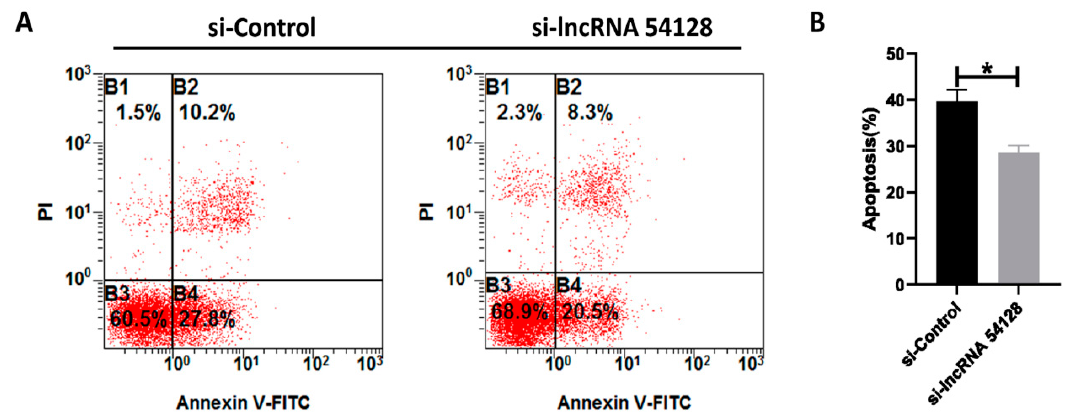
Figure 7. Downregulation of LncRNA 54218 specifically inhibits apoptosis in LMH cells with FAdV-4 infection. LMH cells were transfected with either the siControl or si LncRNA 54218 and then infected with FAdV-4 (MOI = 0.1) for 36 h. ( A ) The cell samples were dual-labelled with Annexin V and PI and analyzed by flow cytometry. ( B ) The proportions of apoptotic cells among the total cells. The data represent the mean ± SD of three independent experiments. p values were calculated using Student’s t test. An asterisk indicates a comparison with the indicated control. * p < 0.05; n.s., not signifi- cant.